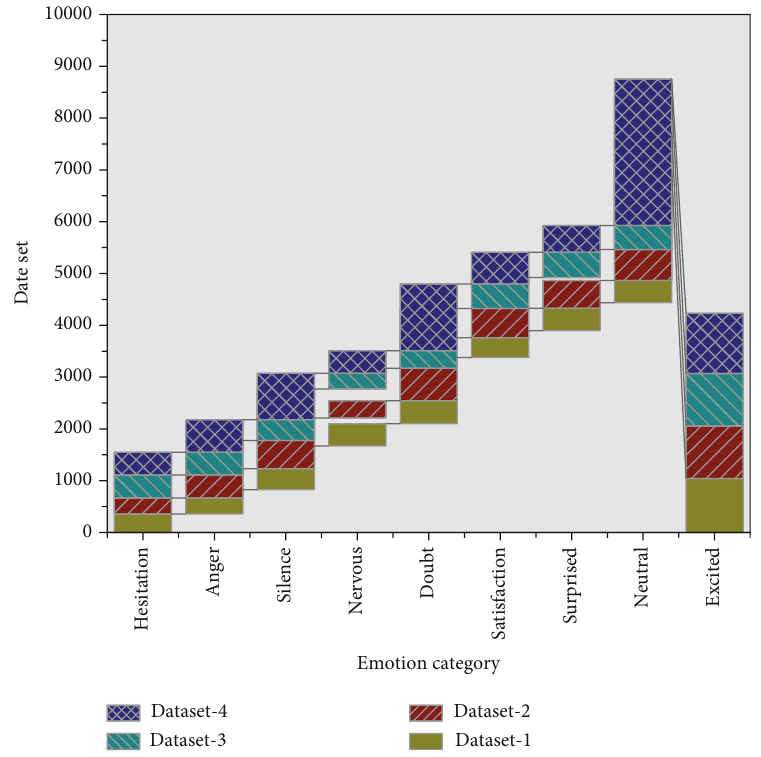
Figure 3: Number of samples for each type of